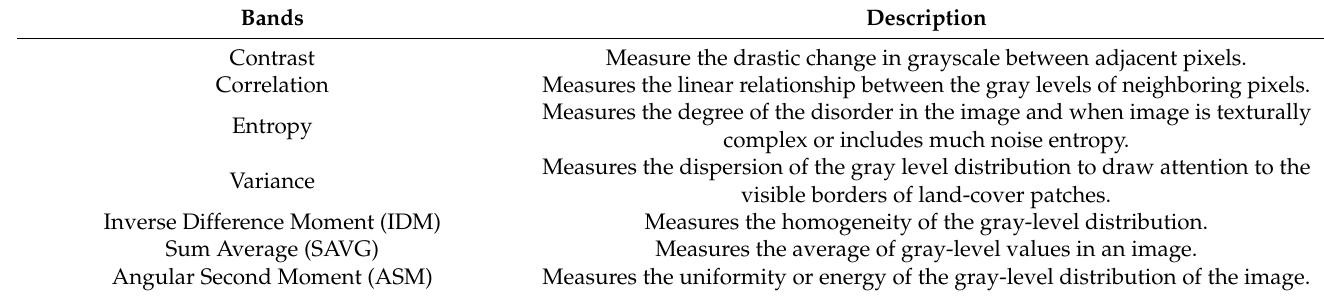
Table 5. Selected GLCM